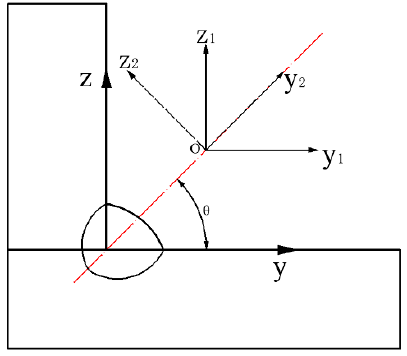
4 of 11 Figure 2. Diagram of the welding and temperature of measuring: ( a ) 3D drawing of the workpiece; ( b ) welding picture. 3. Analytical Modeling Based on ABAQUS software (6.14, Simulia, Providence, RI, USA), a thermal finite element computational procedure is developed to study welding temperature fields during the welding process of fillet-welded joints. The transient heat conduction equation (Equation (1)) is used to analyze the thermal behavior of the MAG process. 𝜕 𝜕𝑥 (cid:3436)𝑘 (cid:3051) 𝜕𝑇 𝜕𝑥(cid:3440) + 𝜕 𝜕𝑦 (cid:3436)𝑘 (cid:3052) 𝜕𝑇 𝜕𝑦(cid:3440) + 𝜕 𝜕𝑧 (cid:3436)𝑘 (cid:3053) 𝜕𝑇 𝜕𝑧(cid:3440) + 𝑄 (cid:3047) = 𝜌𝑐 𝜕𝑇 𝜕𝑡 (1) where k (assuming k x = k y = k z = k ) is the thermal conductivity, Q t is the heat input (caused by the electric arc of the electrode during welding), 𝜌 is the density, and c is the specific heat of the material. It has been assumed that the electrode and the weld plate are of the same material (Q235).